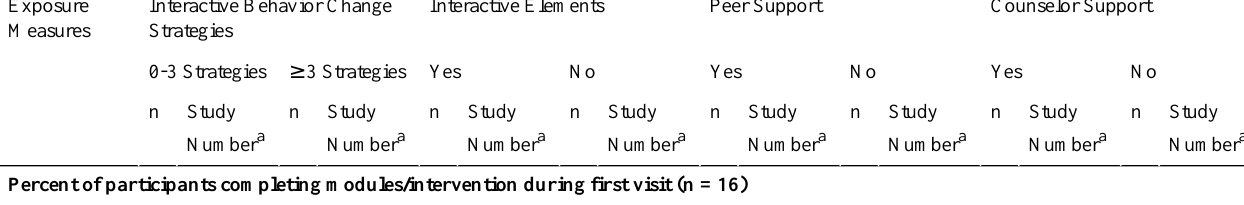
Table 3. Listing of studies by potential exposure-promoting elements (interactive behavior change strategies, interactive elements, peer support, and counselor support) and the result of exposure measures (also see Table 4